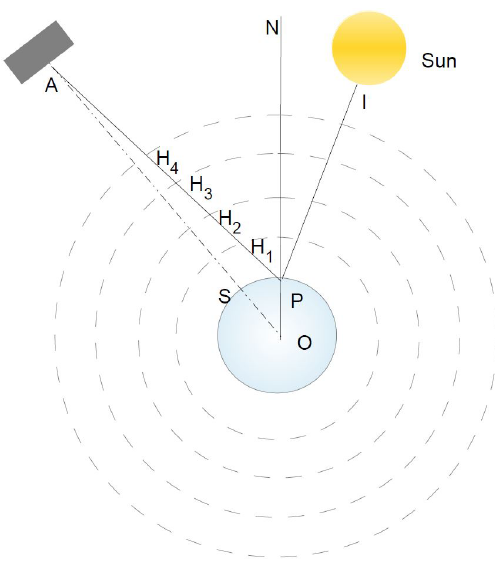
Figure 2. Viewing geometry for the sounders modeled by kCARTA. A is the satellite and point P is being observed by the satellite, while I is the